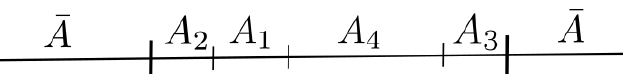
Figure 6: An example in 1 + 1d showing how giving the subdivisions an ordering that is different from the natural ordering can give partial entanglement entropies that do not have the expected symmetry